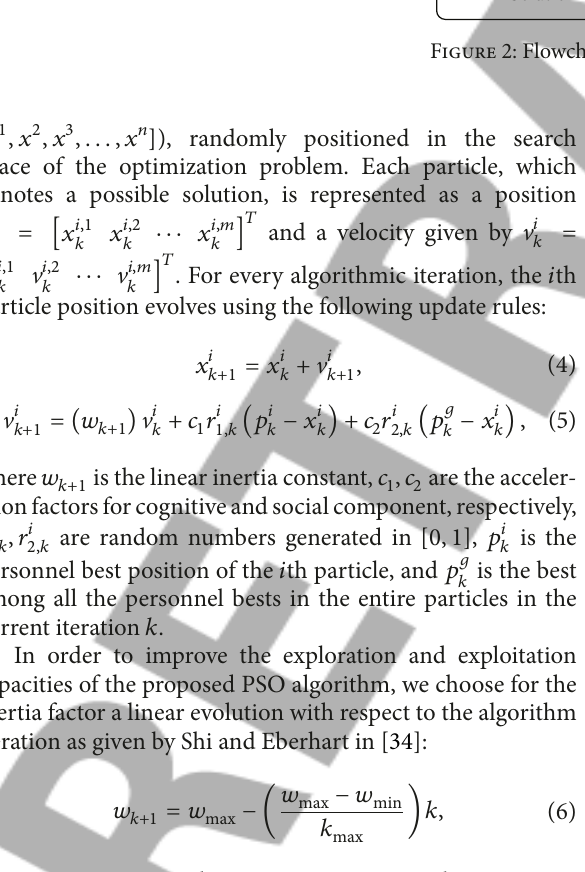
Figure 2: Flowchart of the basic